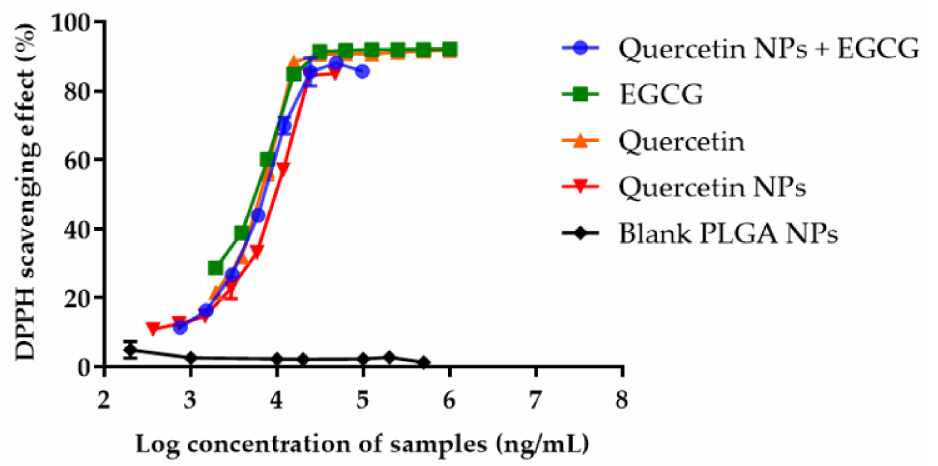
Figure 7. Percentages of the radical scavenging activity of pure quercetin, pure EGCG, quercetin- loaded NPs, quercetin- loaded PLGA NPs combined with EGCG, and blank PLGA NPs, which were determined using the DPPH free radical scavenging